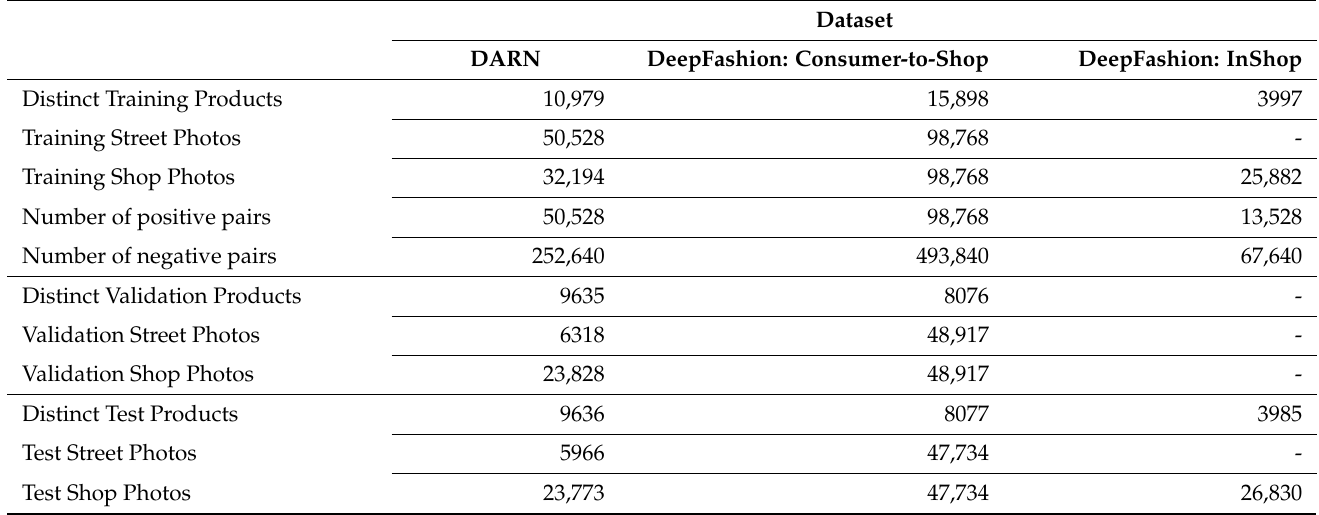
Table 1. The data splitting of DARN, Consumer-to-Shop, and InShop datasets.